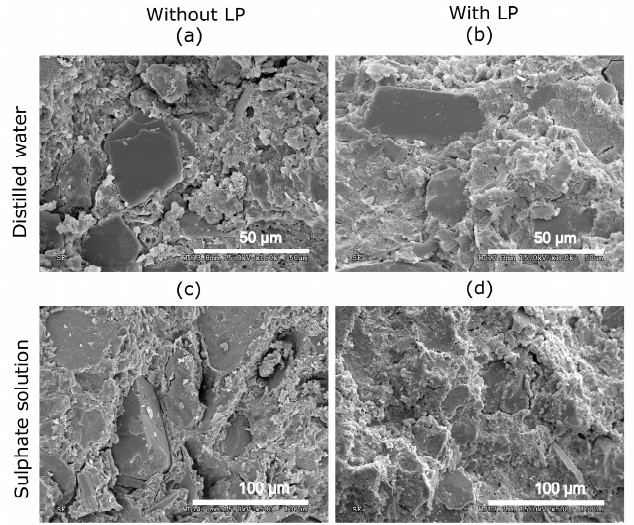
Figure 10. SEM images of cement samples at 6 months ( a ) without the industrial waste and with distilled water, ( b ) with the waste and distilled water, ( c ) without the waste and with the sulfate solution, and ( d ) with the waste and sulfate solution.